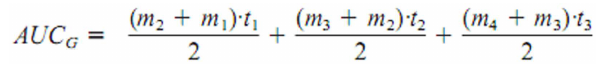
FIGURE 1 | Formula for calculation of area under the curve with respect to ground (AUCg) . Adapted from Pruessner et al. (71). Note: m denotes single measurements; t denotes time interval between